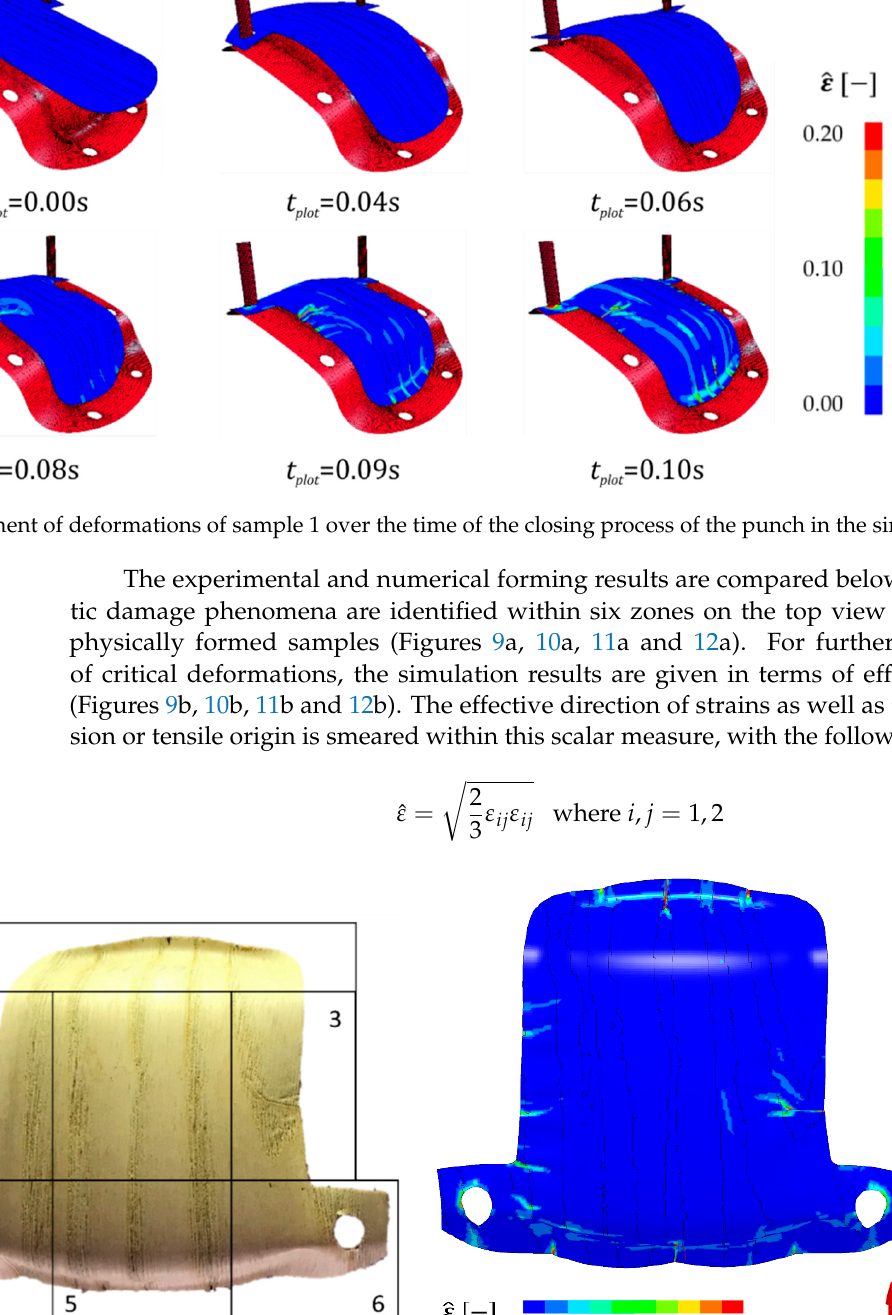
( b ) Figure 10. Forming results of sample 𝟐 ∥ . ( a ) Experiment; ( b ) simulation with output of equivalent strain. ( b ) Figure 11. Forming results of sample 𝟑 ∥ . ( a ) Experiment; ( b ) simulation with output of equivalent strain.